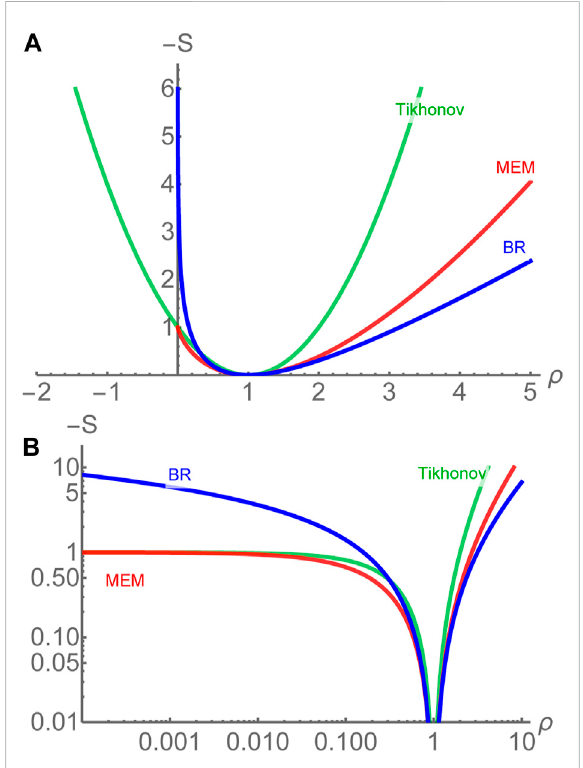
FIGURE 2 Comparison of the regulators of the Tikhonov approach (green), the MEM (red) and the BR method (blue) in linear scale (A) and double logarithmic scale (B) for the choice of m = 1. The Shannon-Jaynes regulator accommodates ρ = 0 but appears fl at for spectral functions with values close to zero. The BR prior shows the weakest curvature for ρ > m among all